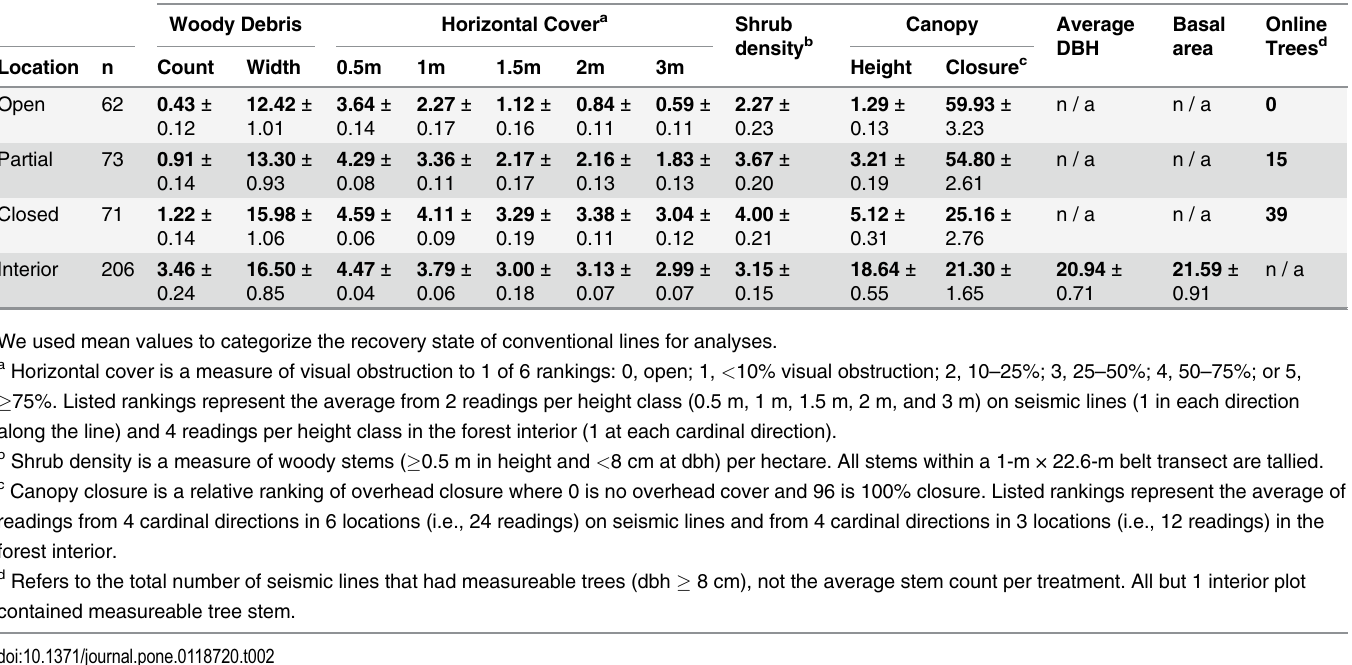
Table 1. Behavioral response of American Marten ( Martes americana ) to seismic line types as compared to undisturbed forest interior locations in northwest Canada. Seismic Line Type